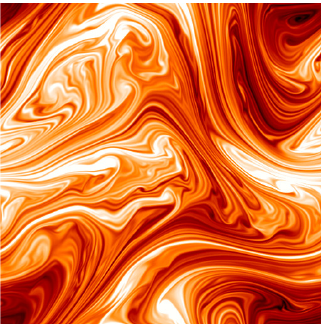
Figure 5: High resolution numerical simulations of 2D MHD turbulence at resolution 2048 (cid:214) 2048 (courtesy by H. Politano). Here, the authors show the current density 𝐽 ( 𝑥, 𝑦 ), at a given time, on the plane ( 𝑥, 𝑦